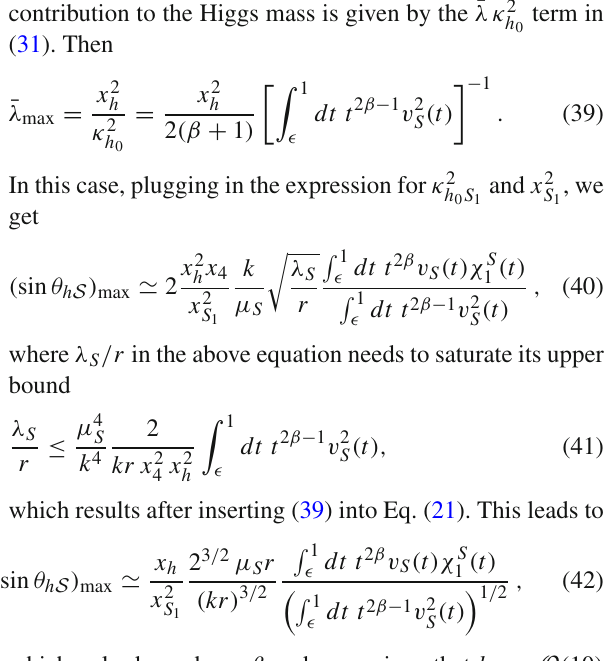
Fig. 2 Maximum allowed value for the parameter ( sin θ h S ) max describing the mixing between the lightest Higgs mode and the first KK resonance of the Z 2 -odd scalar as a function of β , for fixed values of M KK and k / m Pl . In the left and middle plots, we show this depen- dence for different values of μ S r and positive ¯ λ . In the left plot, we